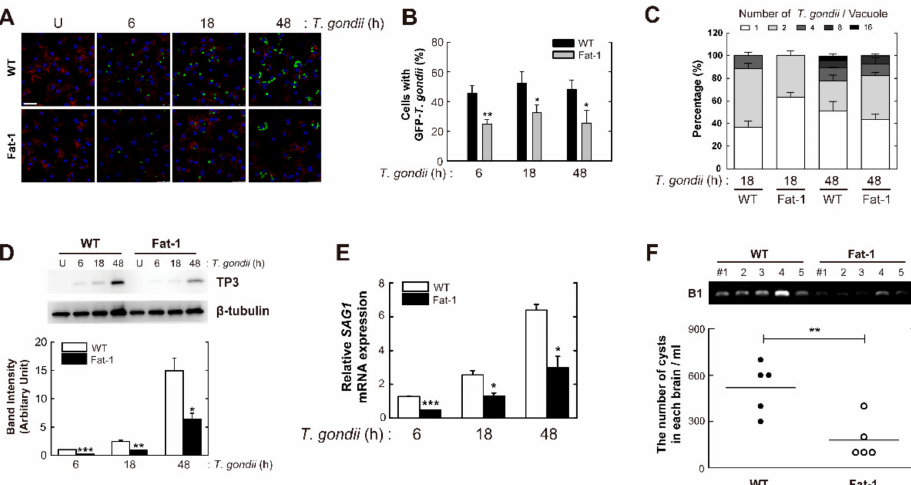
Figure 1. Endogenous omega-3 polyunsaturated fatty acids ( ω -3 PUFAs) are required for the inhibition of intracellular T. gondii proliferation in macrophages. ( A – C ) Bone marrow-derived macrophages (BMDMs) from wild-type (WT) and Fat-1 transgenic mice were infected with T. gondii tachyzoites expressing green fluorescent protein (GFP-RH strain) (Multiplicity of infection (MOI) = 1) for the indicated time periods. ( A ) After fixation of cells, F-actin in the cytoskeleton (red) and nuclei (blue) were stained with Texas Red ® -X phalloidin and 4 (cid:48) ,6-diamidino-2-phenylindole (DAPI), respectively. The number of GFP-RH strain was analyzed by confocal microscopy. ( B and C ) GFP-RH-infected cells ( B ) and GFP-RH strain per vacuole ( C ) were counted. Scale bar = 25 µ m. ( D and E ) BMDMs from WT and Fat-1 transgenic mice were infected with T. gondii RH strain (MOI = 1) for the indicated time periods. ( D ) Immunoblot analysis was performed to determine protein expression of TP3 and β -tubulin. A representative gel from three independent experiments with similar results is shown (top), Densitometry analysis (bottom) ( E ) SAG1 mRNA expression was evaluated by quantitative polymerase chain reaction (qPCR) analysis. ( F ) WT and Fat-1 transgenic mice ( n = 5 per group) were infected with 40 cysts of T. gondii ME49 strain (intraperitoneal injection). After 3 weeks, B1 gene expression in brain homogenates was detected by PCR analysis (top). Cysts in the brain were counted under a microscope (bottom). Data are representative of three independent experiments and are presented as means ± SD. * p < 0.05, ** p < 0.01, *** p < 0.001, compared with control cultures or control